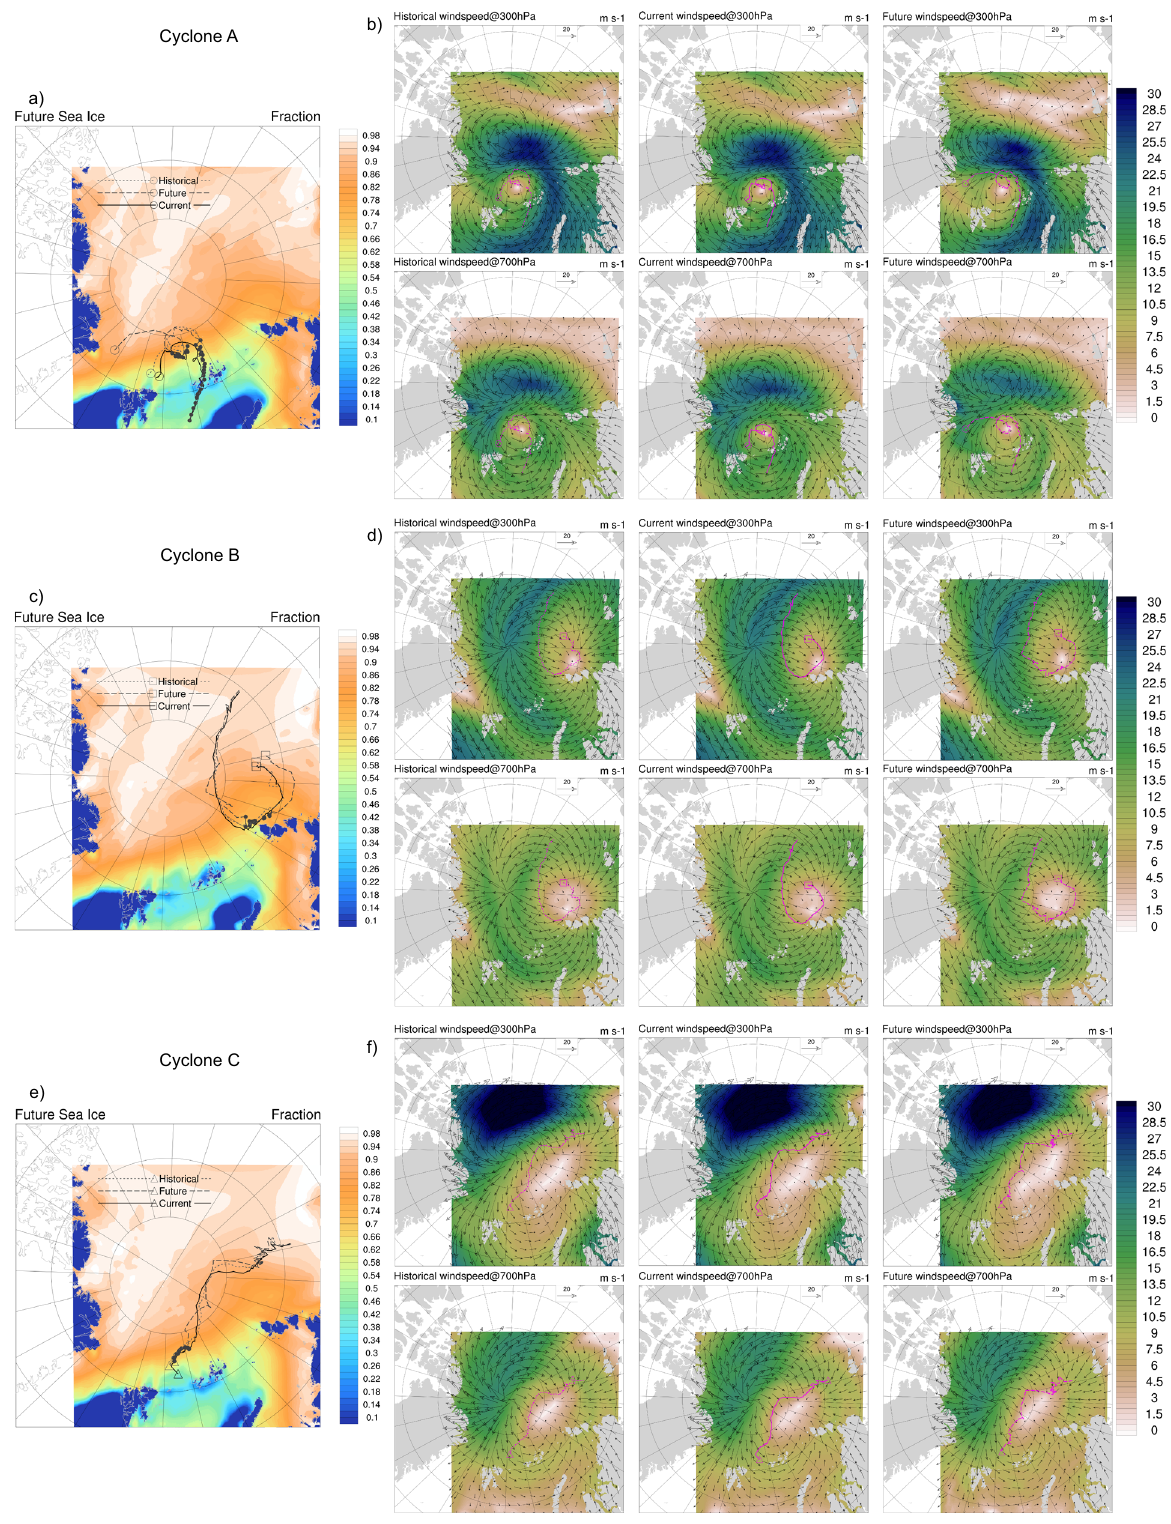
Fig. 2 | Alterations in upper-level atmospheric steering fl ow and cyclone tra- jectoriesinresponsetoclimateperturbations. Panels a , c , e showtheaveragesea ice concentration (fraction) in the future climate simulations of Cyclones A – C respectively, with the cyclone tracks from historical, current, and future climate simulations overlain. Openmarkersshow theendofthetrajectories, fi lled markers